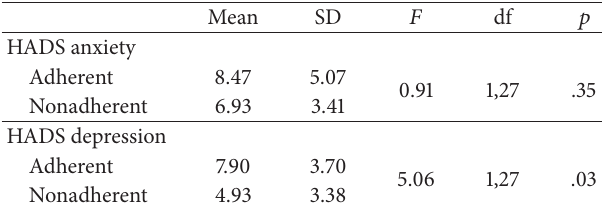
Table 3: Anxiety and Depression scores for adherent and nonadher- ent